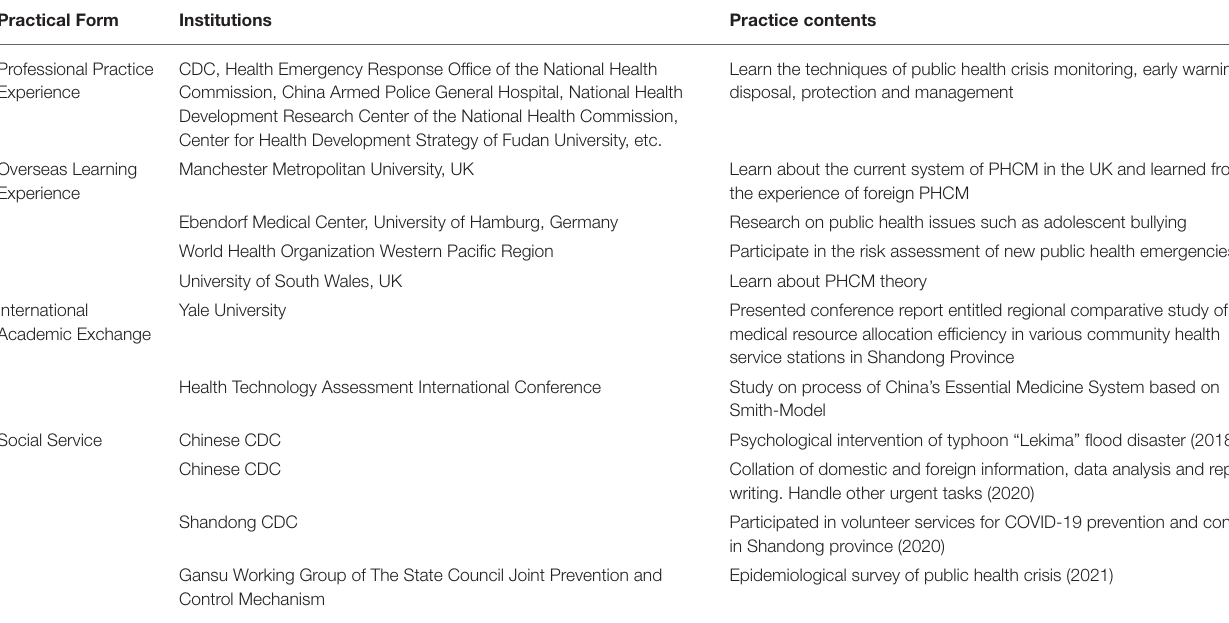
TABLE 3 | Hands-on training of